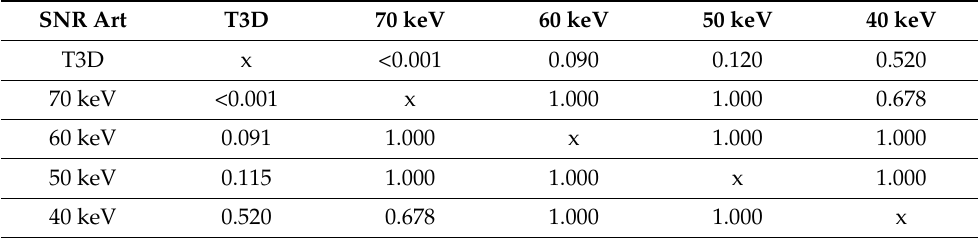
Table 7. Comparison of arterial SNR between T3D and low keV images.